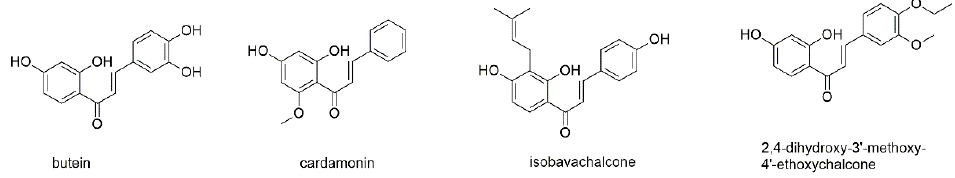
Figure 7. Chalcones with reported activity against myeloma cell lines.